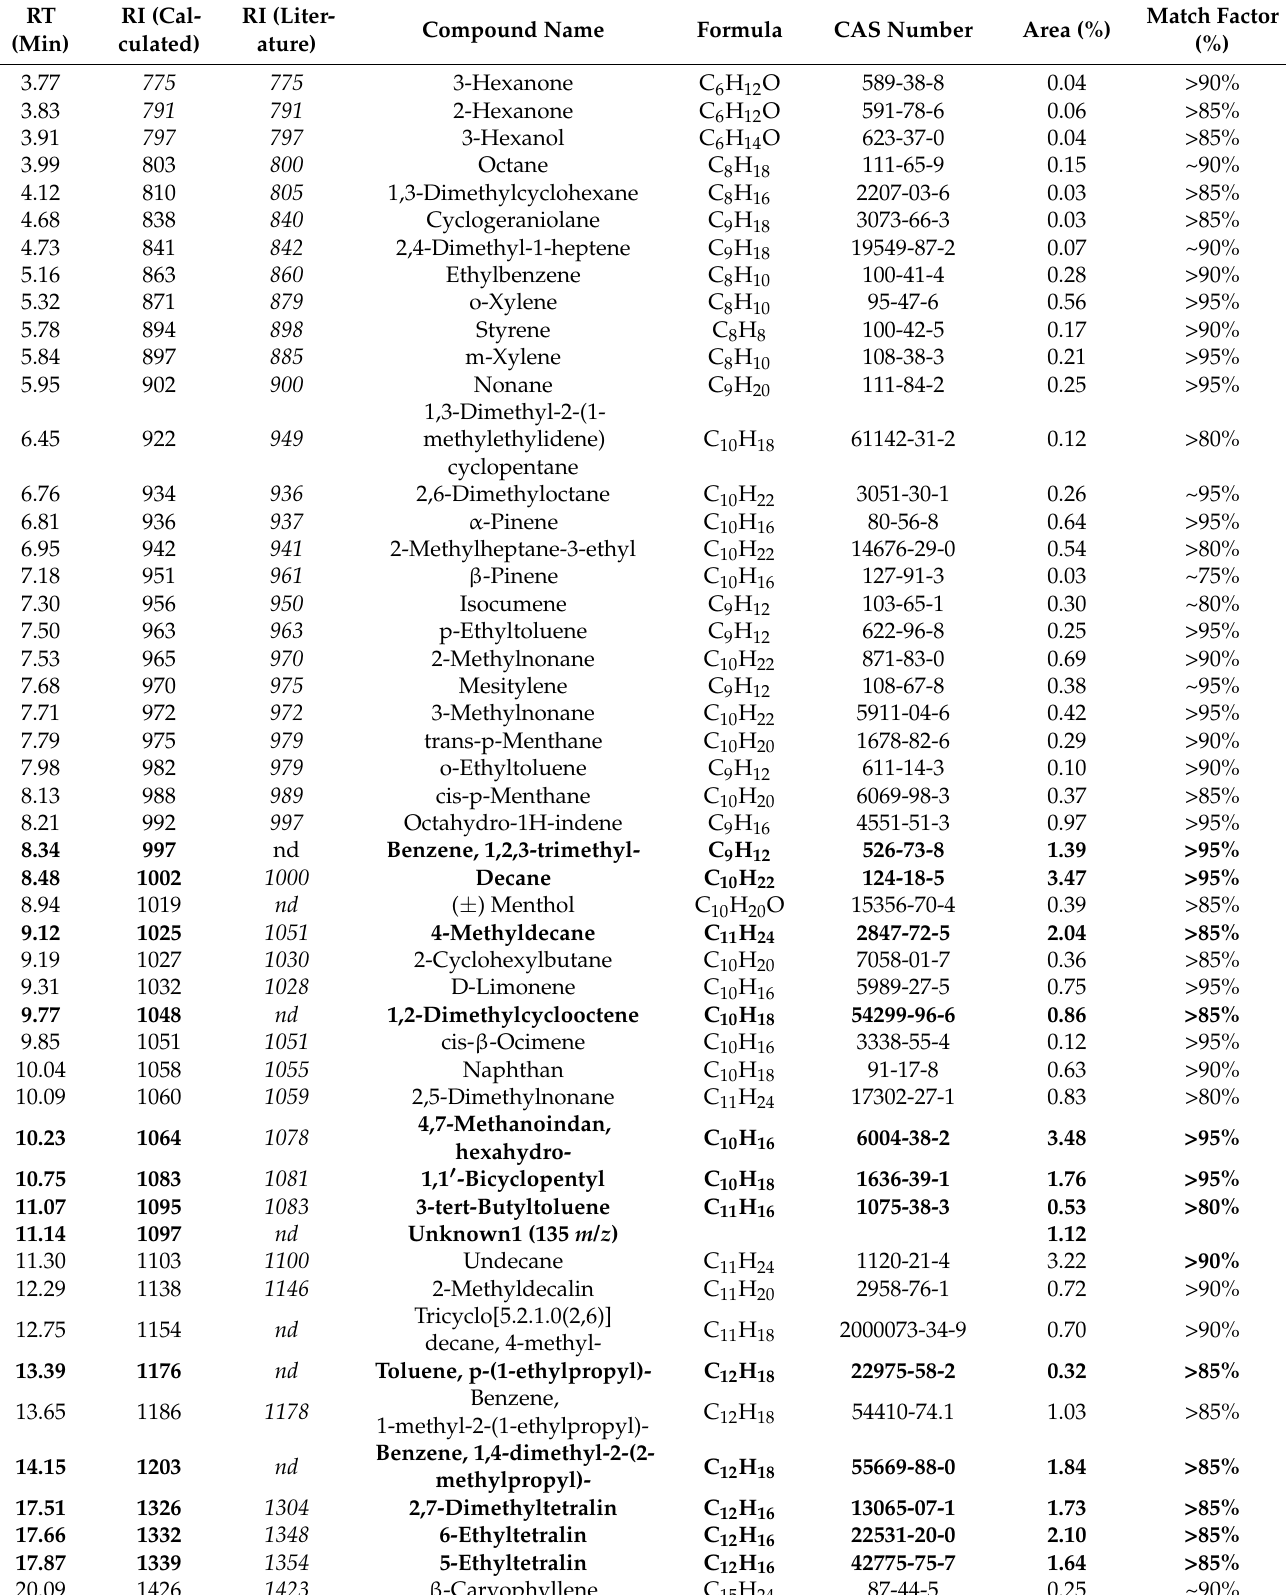
Table 1. Identified volatile organic compounds in Lactuca sativa . Retention indices written in italics come from the NIST webbook. The 20 most intensive compounds are marked in bold. nd indicates no